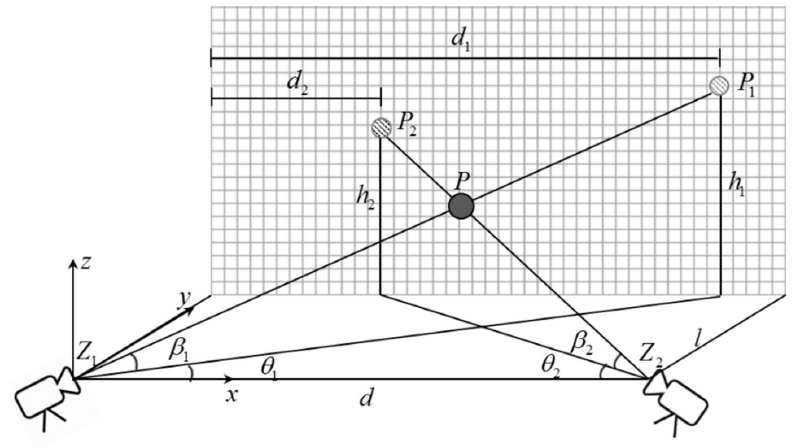
Figure 1. The setup of parameters for the trajectory tracking problem (adapted from [19]).